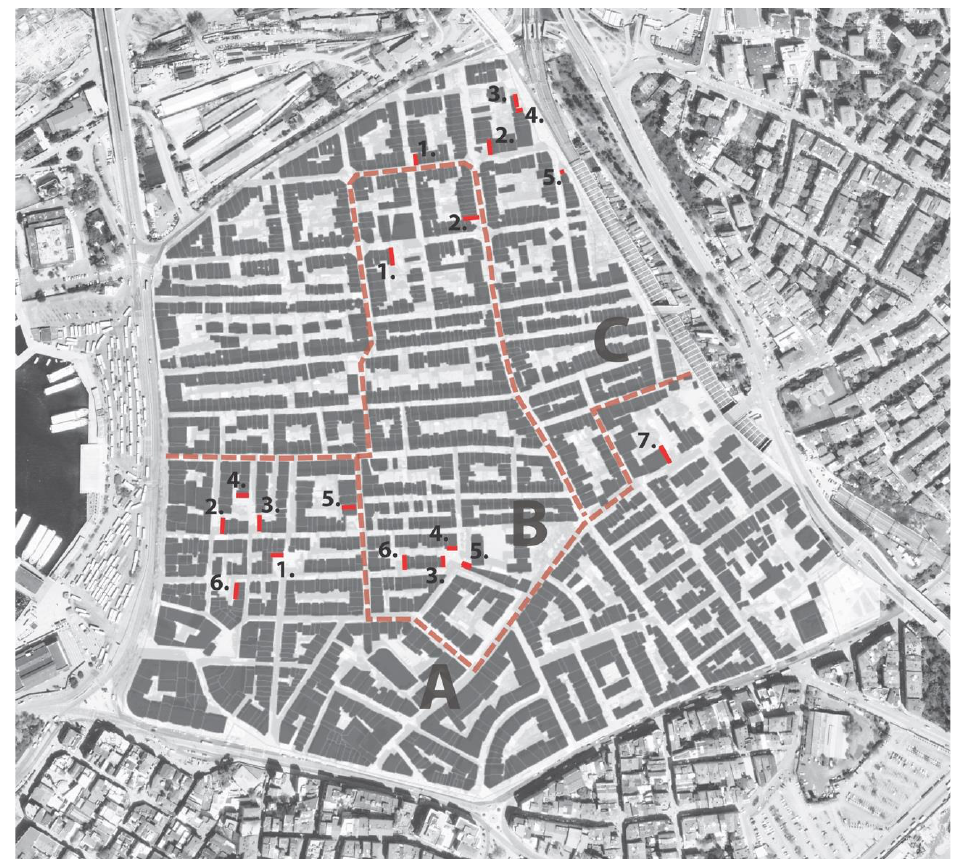
Figure 18 Character areas in Yeldeğirmeni Neighborhood and the location of the